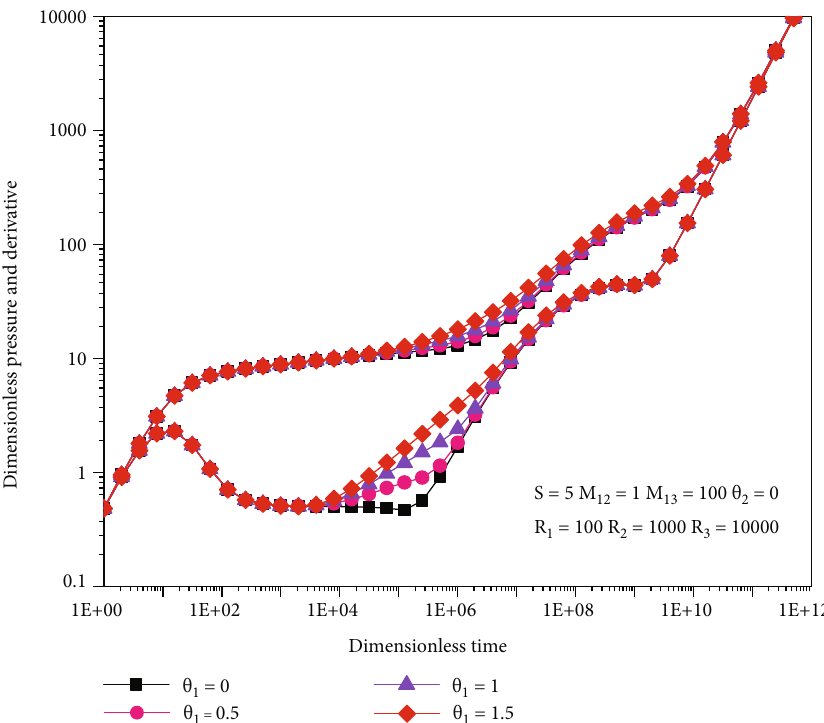
Figure 10: In fl uence of the mobility change index in the transition zone of the homogeneous radial composite reservoir on the well bottom pressure performance.